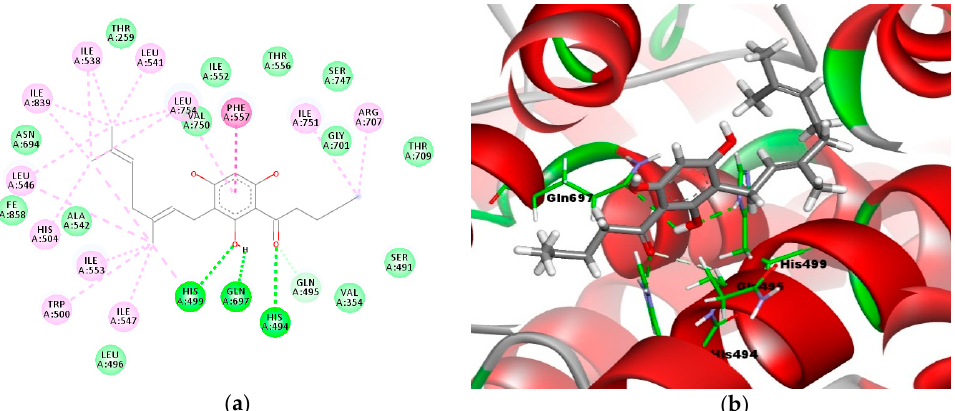
Figure 4. Molecular binding models of compound 3e in the active site of the LOX-1 homology model: ( a ) 2D diagram; ( b ) 3D diagram. In ( a ), green line indicates hydrogen-bonding interactions, light green line indicates covalent bonding, pink line indicates hydrophobic interactions, and purple line indicates π – π interactions. In ( b ), the atoms are colored gray for carbon, red for oxygen, blue for nitrogen, and white for hydrogen; amino acid residues are in green.